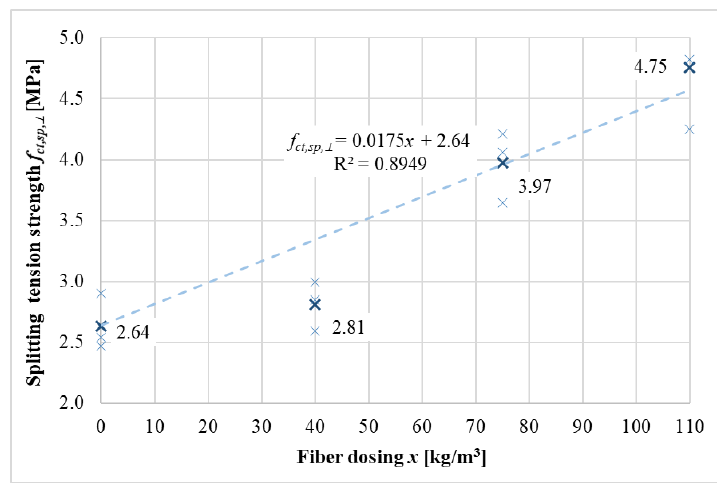
Figure 10. Regression analysis to determine the functional dependence of the splitting tensile strength perpendicular to the direction of filling f ct,sp, ⊥ on fiber dosage x .